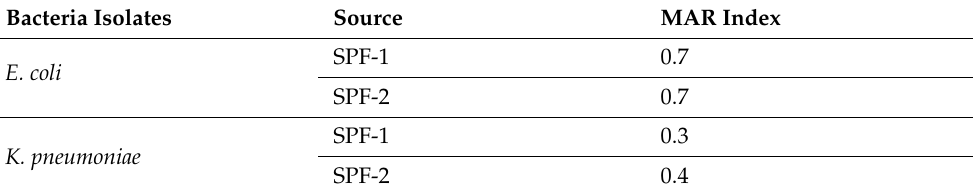
Table 4. Multiple antibiotic resistance indices (MAR) of the Gram-negative bacteria species of significance to human health isolated from effluent samples collected from two seafood processing facilities (SPF) in Tema, Ghana during 2021 and